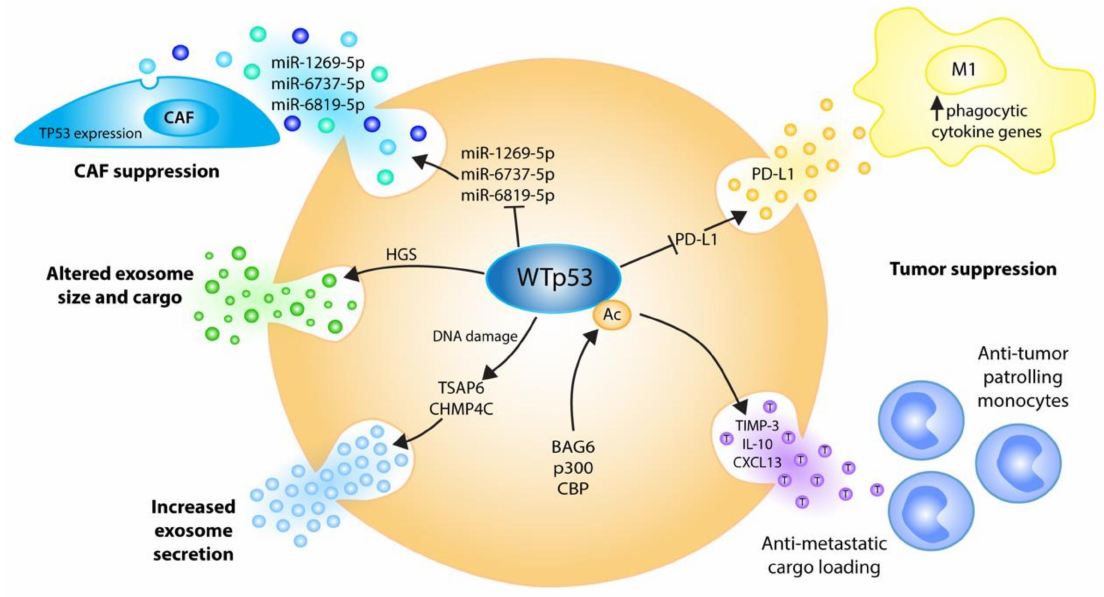
Figure 3. Wild-type p53 regulates the EVs’ biogenesis, cargo and cancer functions at multiple levels to communicate tumor-suppressive signals to the microenvironment. Stress-induced p53 transactivates TSAP6 and the ESCRT-III subunit CHMP4C, resulting in increased exosome secretion [79,80]. p53 alters exosome size and cargo via ESCRT-0 subunit HGS [81]. DNA damage-triggered p53 acetylation by BAG6 / CBP / p300 induces anti-metastatic EV cargo, causing the recruitment of tumor-suppressive patrolling monocytes to sites of future metastasis [82]. p53 suppresses cancer-associated fibroblasts’ (CAF) proliferation by repressing exosomal TP53 -targeting miRNAs [83]. p53 supports tumor cell phagocytosis under chemoimmunotherapy by repressing the release of PD-L1-positive EVs